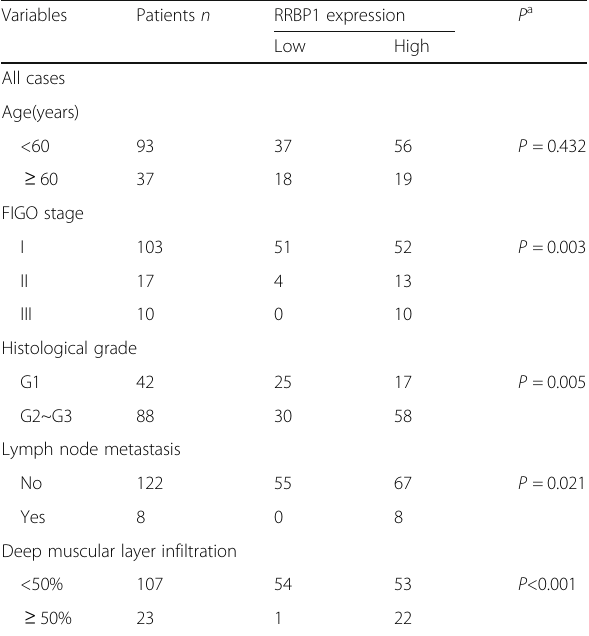
Table 1 Association analyses between the expression levels of RRBP1 and the clinicopathological characteristics of endometrial endometrioid adenovarcinoma